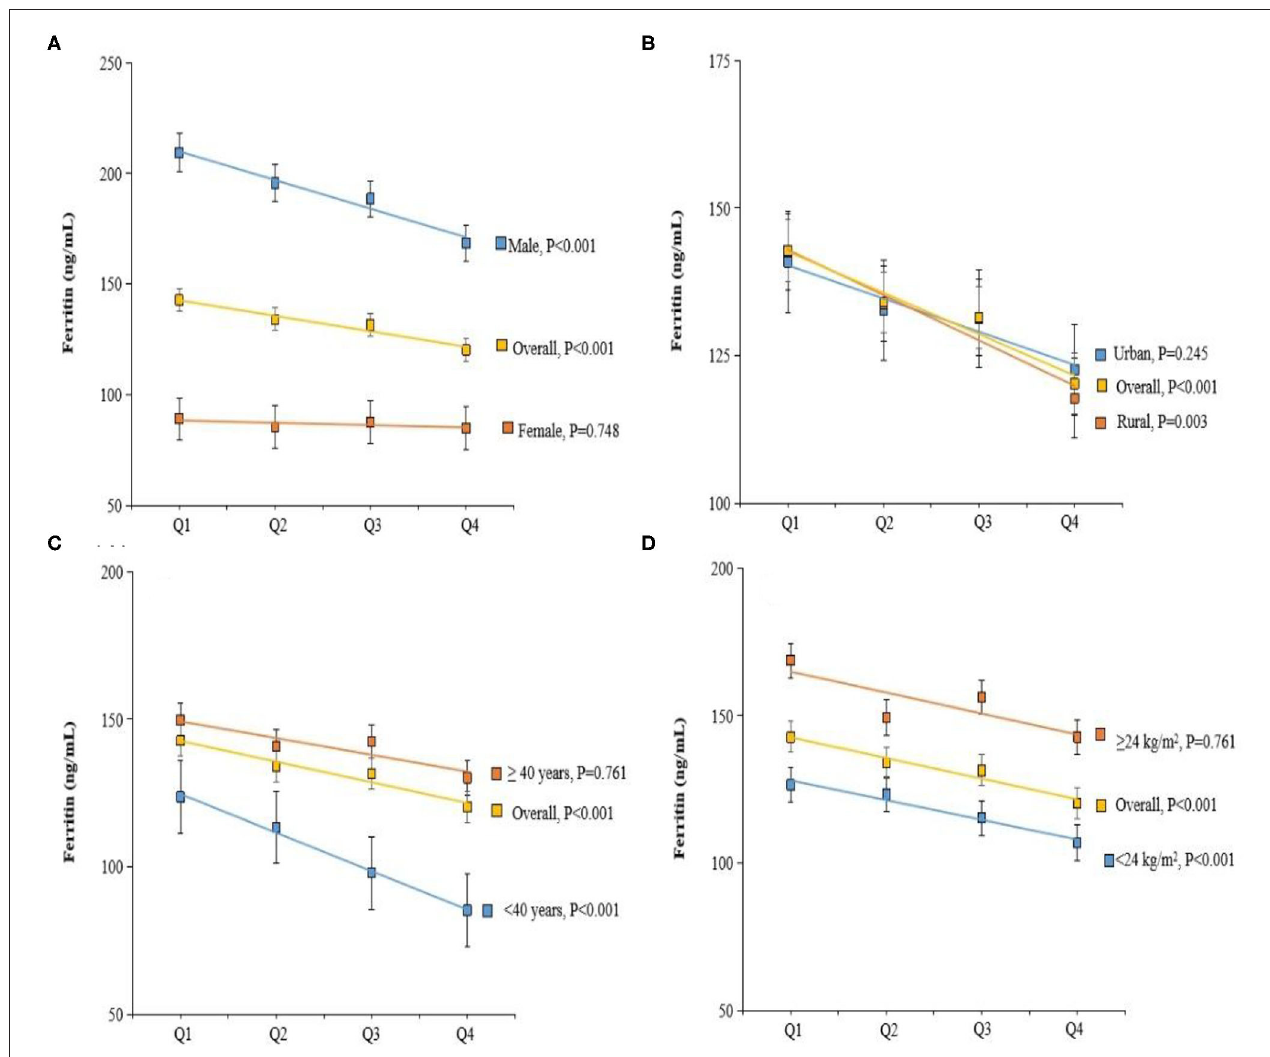
FIGURE 2 | Adjusted Ferritin by dietary vitamin C intake, gender (A) , residence (B) , age (C) , and body mass index (BMI) (D) . Values were means adjusted for age, gender, BMI, smoking status, and residence.